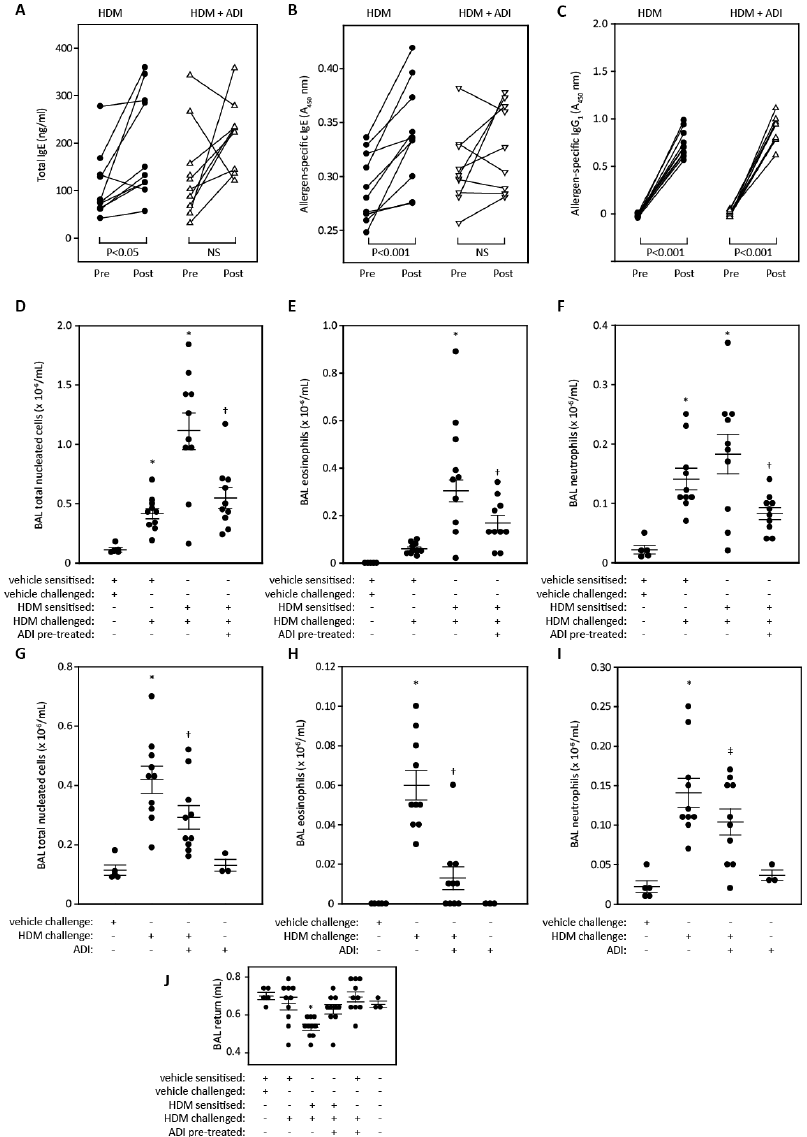
Figure 6. Prophylactic action of Compound 4 against i.t. aerosol sensitisation to an extract of mixed HDM allergens and its inhibition of acute allergic and innate cell recruitment in C57BL/6 mice challenged with mixed HDM allergens (25 µ L, i.t., 10 µ g equivalent Der p 1). ( A – C ) Pre- and post-immune serum concentrations of IgE, HDM allergen-specific IgE and allergen-specific IgG 1 in mice with and without ADI treatment (Compound 4 , 10:1 molar ratio to Der p 1) during the intranasal sensitisation protocol. Responses for individual animals are shown. ( D – F ) BAL cell profiles in C57BL/6 mice sensitised to mixed HDM allergens following challenge with vehicle or mixed HDM allergens and the modulating effect of Compound 4 . The ADI was administered (25 µ L at 40 µ M, i.t.) 120 min prior to i.t. allergen provocation (25 µ L, i.t.). Test compound was dosed at a 10:1 molar ratio with respect to Der p 1. The mixed HDM preparation contained a dose of 10 µ g Der p 1. * p < 0.001–0.01 vs. vehicle challenge; † p < 0.01 vs. HDM challenge. ( G – I ) BAL leukocyte profiles in unsensitised C57BL/6 mice following i.t. challenge with vehicle or mixed HDM allergens and the modulating effect of ADI Compound 4 on the innate recruitment of leukocytes. The ADI was administered (25 µ L at 40 µ M, i.t.) 15 min prior to i.t. allergen provocation. * p < 0.001, ‡ p < 0.05 vs. vehicle challenge; † p < 0.001–0.05 vs. HDM challenge. ( J ) BAL fluid returns in the study groups. * p < 0.01–0.05 vs. other treatments. Data for individual animals are shown in ( D – J ). Cross-hairs and whiskers denote mean ± s.e. mean,